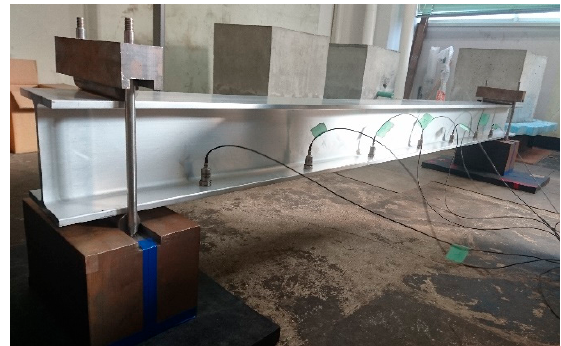
Figure 7. Vibration experiment in this study.